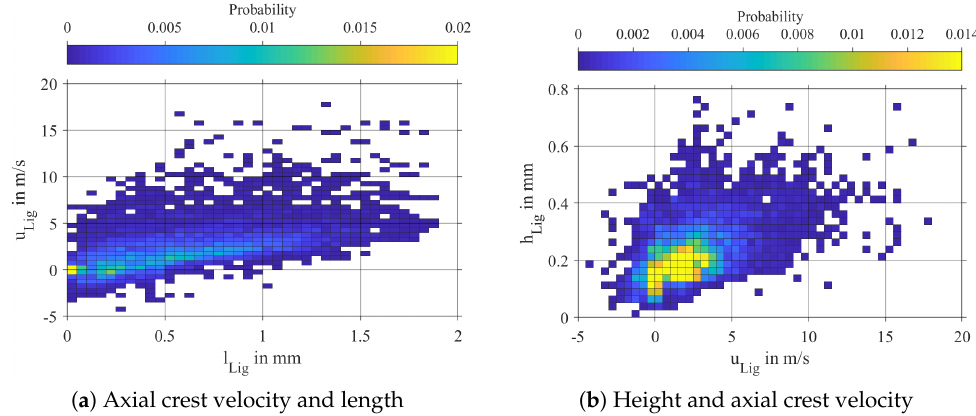
Figure 9. Interdependencies between axial crest velocity and ligament length scales for p g = 5bar, u g = 70m/s, h a =